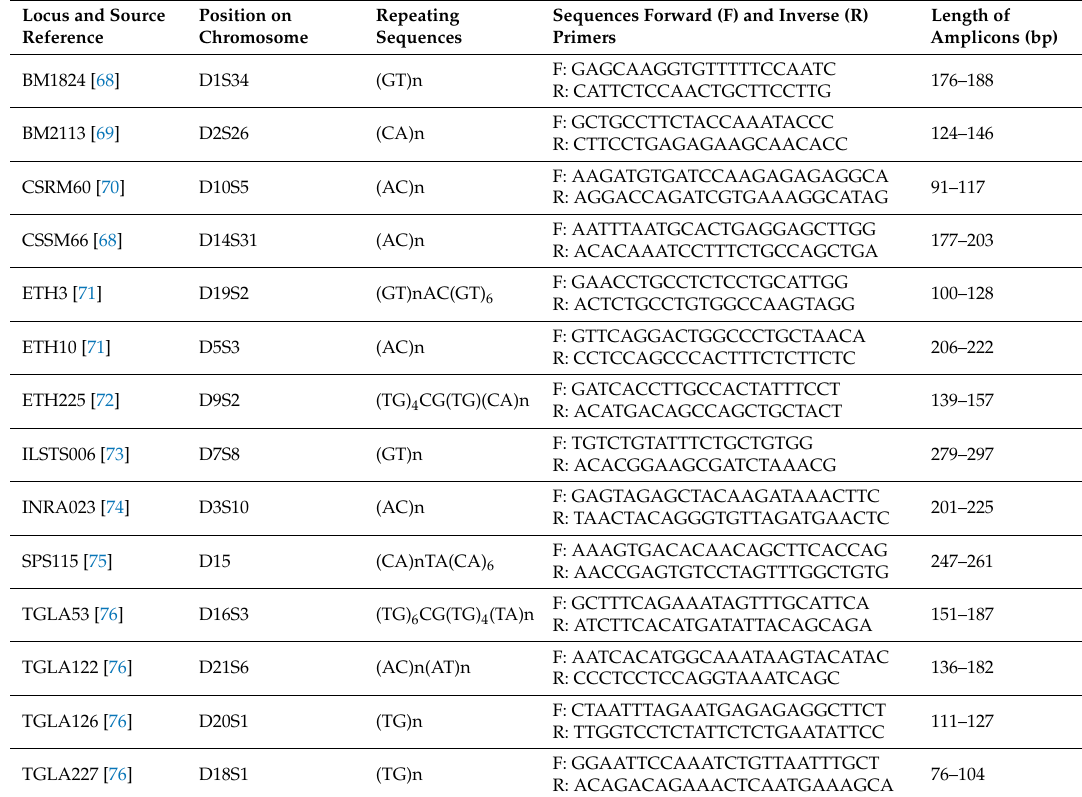
Table A1. Description of microsatellite